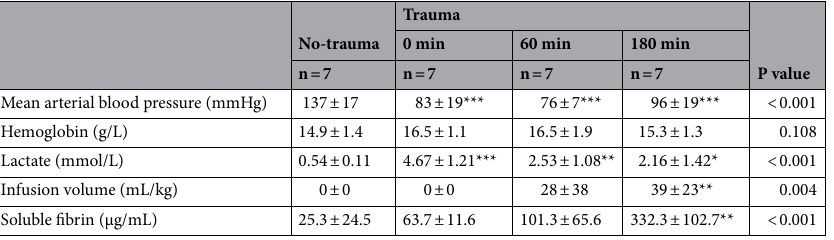
Table 2. General characteristics and coagulation activation of each group. No-trauma and 0 min groups were not infused with Ringer’s lactate solution. P values are obtained using one-way ANOVA. *** P < 0.001 using